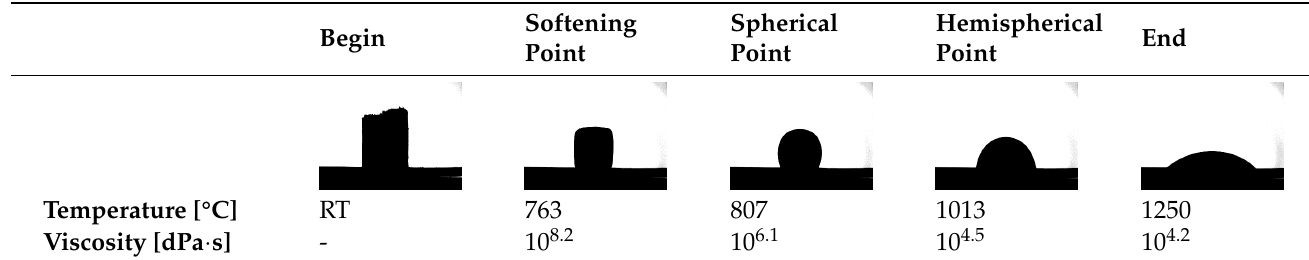
Figure 3. Temperature-dependent surface curve in the hot stage microscope. Table 5. Sample shapes for Glass 18-06 during heating in the hot stage microscope.